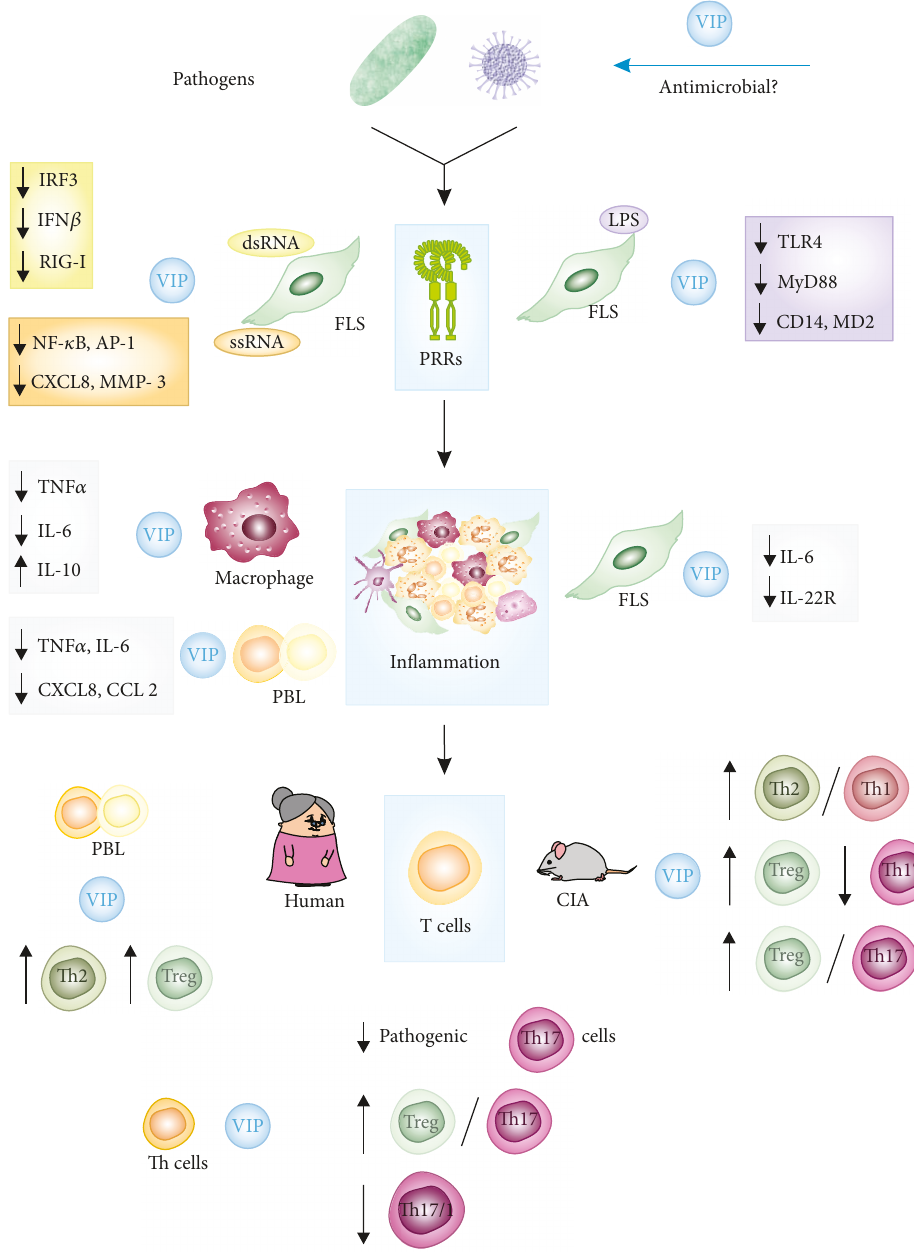
Figure 1: E ff ect of VIP on RA. VIP is a microenvironment mediator capable of modulating all the stages in RA from the arrival of pathogens to the di ff erentiation of Th cells. It exerts a direct antimicrobial activity against a variety of pathogens, modulates TLR expression and function in several cells, decreases proin fl ammatory mediators in lymphocytes and FLS, and modulates the di ff erentiation of several Th cells, including a decrease in the pathogenic pro fi le and plasticity of some of them. PRRs: pattern recognition receptors; FLS: fi broblast-like synoviocytes; PBL: peripheral blood lymphocytes; CIA: collagen-induced arthritis mouse